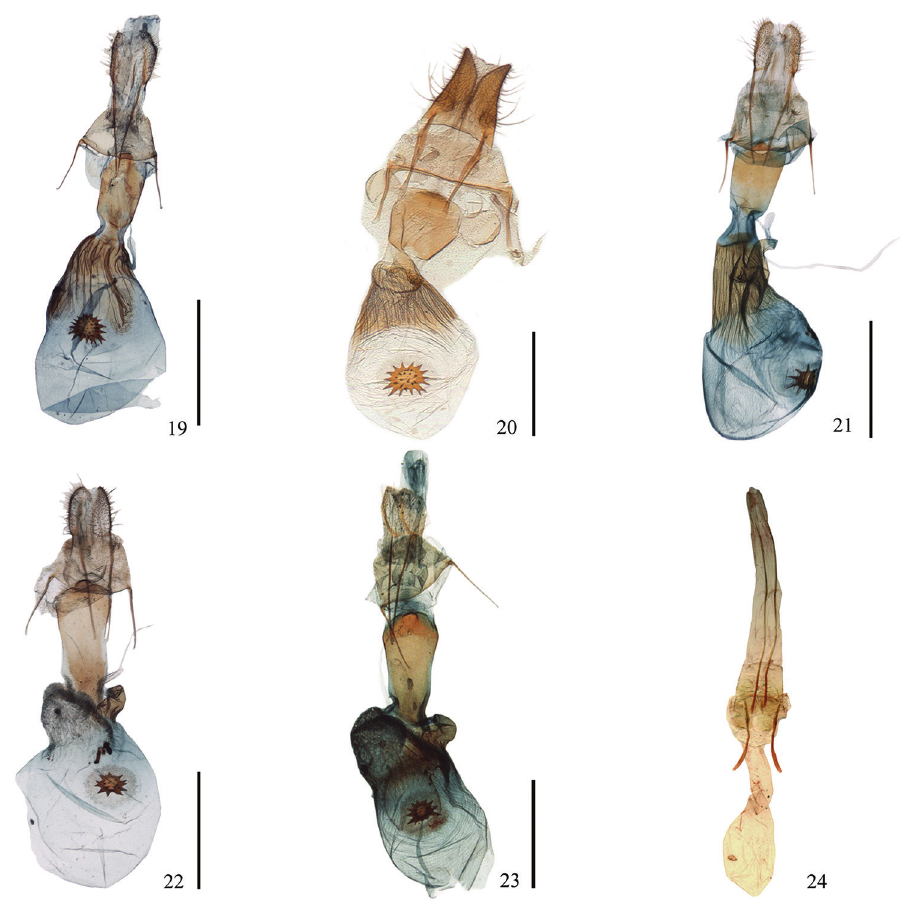
Ninodes albarius Beljaev & Park, 1998, Tinea , 15 (3): 243, figs 1, 4, 13. Holotype ♂ , Gwangleung, Korea (NIAST)